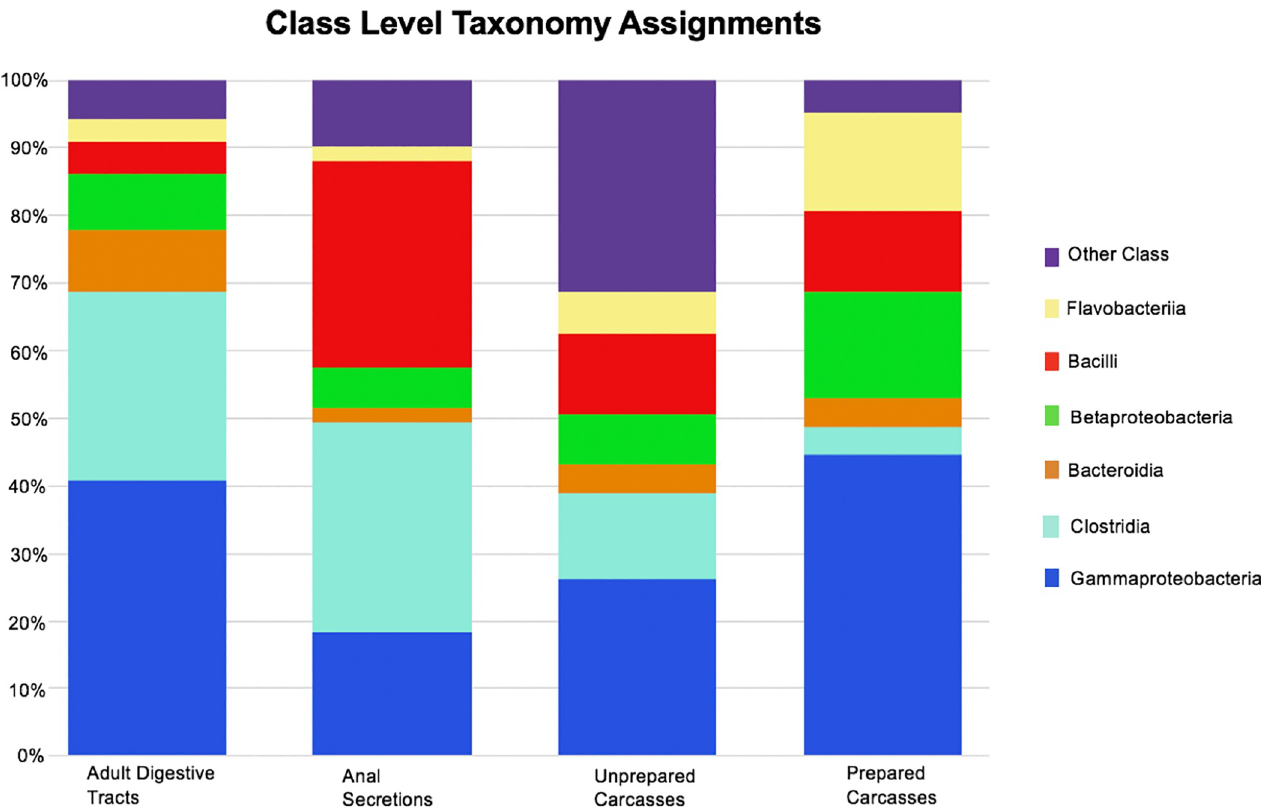
Fig 1. Relative abundances of bacterial classes within different sample types. Bar lengths show the average relative percentage of all sequences for bacterial classes found within each sample type. All classes not specifically identified were assigned to the ‘Other’ category that also includes unidentified bacterial classes.